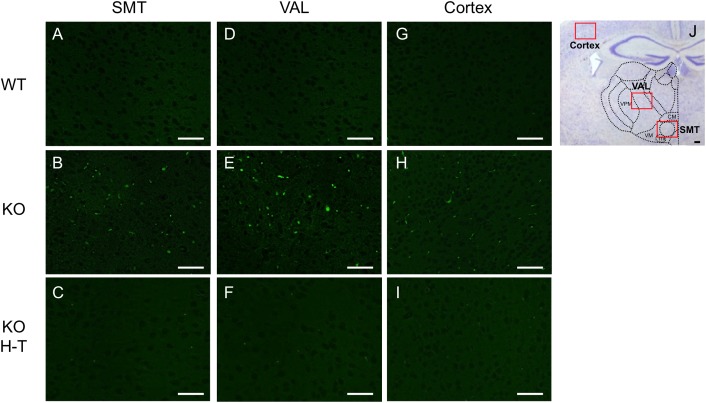
Fluoro-Jade C staining of WT, homozygous KO mice fed with a thiamine-restricted diet, and homozygous KO mice fed with a thiamine-restricted diet for 2 days and reverted to a high-thiamine diet.Brain slices of a WT and homozygous KO mouse fed with thiamine 1.71 mg/100 g food for 8 days, and surviving homozygous KO mice with high-thiamine diet showing the SMT (A, B, C), VAL (D, E, F), and cortex (G, H, I). Overview of the specific regions of the thalamic area of a WT mouse (J), with red boxes indicating the region of each part. Scale bar, 100 μm.